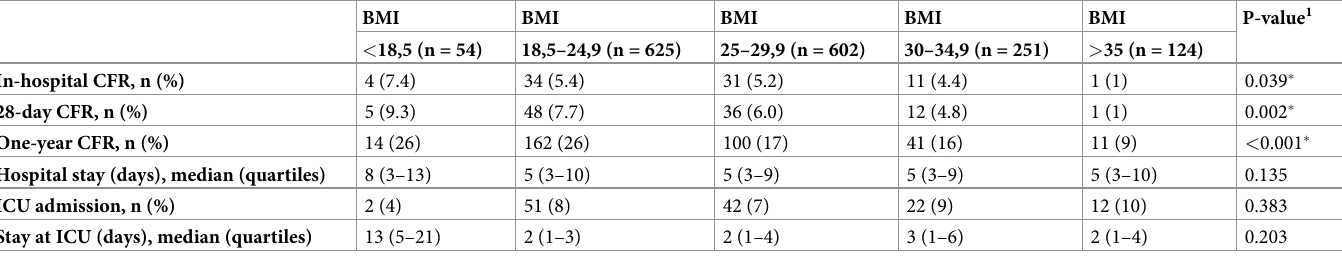
p = 0.005, and p < 0.001, respectively). There was no significant difference in the prevalence of chronic liver or lung diseases or immunosuppressive disorders between the BMI groups. Neither the proportion of patients with bacteremia nor those that fulfilled the criteria for severe sepsis differed significantly between the BMI groups. B-lymphocytes increased signifi- cantly with BMI (p < 0.001), and a significant negative association was found between BMI and the neutrophile-to-lymphocyte-count ratio (NLCR) (p = 0.006). No significant difference was found in C-reactive protein (CRP) or leukocyte levels (LPK) as well as time-to antibiotic inter- vention from the onset of the disease or upon their arrival at the hospital. Moreover, over 98% of the patients in all BMI groups were judged to have received adequate empirical antibiotic treatment, i.e. treatment according to local guidelines or trailing resistance testing. The initial antibiotic therapy is presented in Table 1, and the presented drugs were either given alone or as a part of combination therapy. Erysipelas, soft-tissue infection and diverticulitis diagnoses were more common as BMI increased while the frequency of pneumonia diagnosis was significantly lower with increasing BMI, as presented in Table 2. In a univariate analysis, the CFR diminished significantly with increasing BMI, as presented in Table 3. The identified negative correlation between BMI and CFR was significant for in- hospital (p-value = 0.039), 28-day (p-value = 0.002), and one-year CFR (p-value < 0.001). The length of hospital and ICU stay as well as the proportion of patients admitted to the ICU did not differ between the BMI groups. When BMI was included as a continuous variable in a multiple-logistic regression with other possible covariates, we could still discern that increasing BMI was associated with decreasing 28-day CFR (OR = 0.93; 95% CI 0.88–0.98; p-value = 0.009) and one-year CFR (OR = 0.94; 95% CI 0.91–0.97; p-value < 0.001). The analysis also identified age and existing Table 3. Outcome variables by